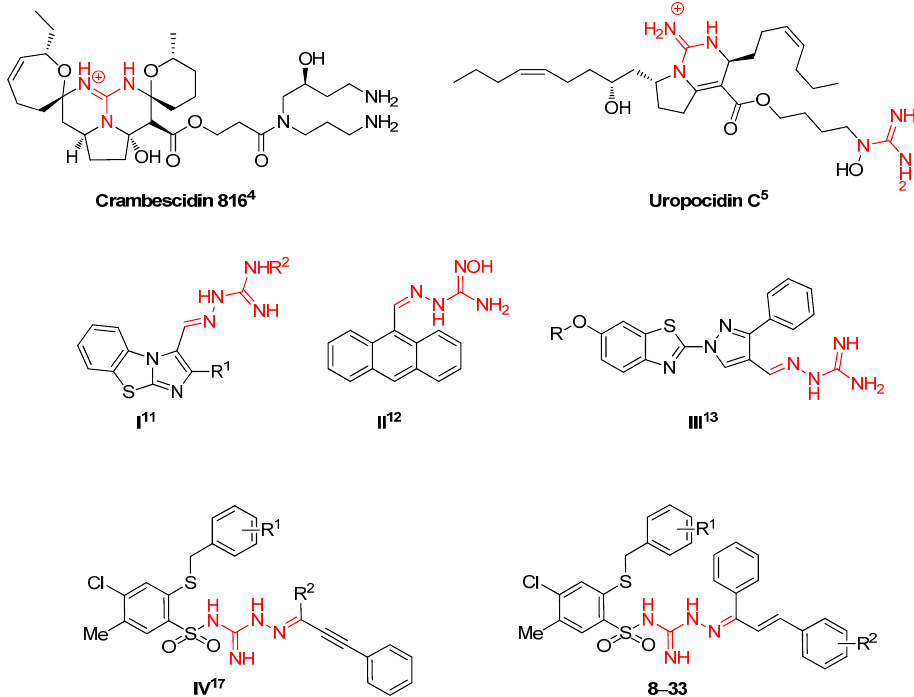
Figure 1. Some known cytotoxic compounds with the amidrazone/guanidine scaffold and the new designed derivatives 8 – 33 .